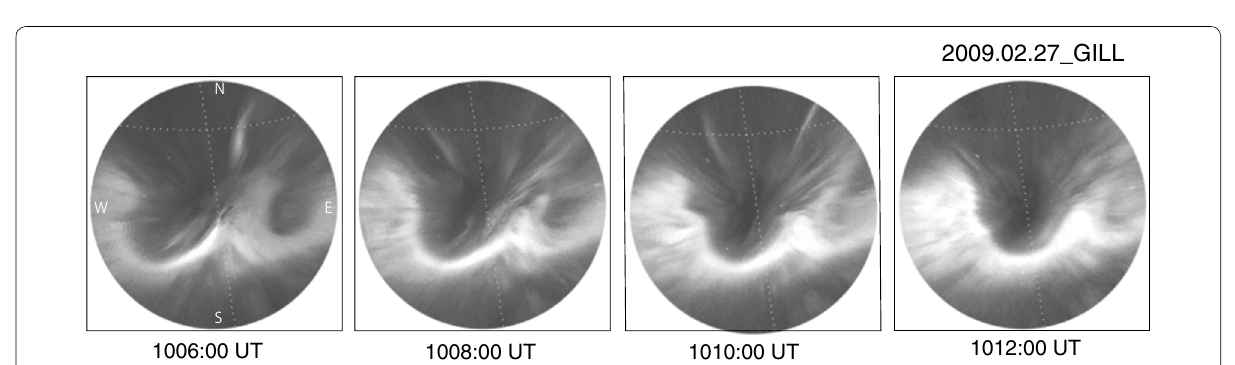
Fig. 2 Typical growth characteristics of an O-type omega band